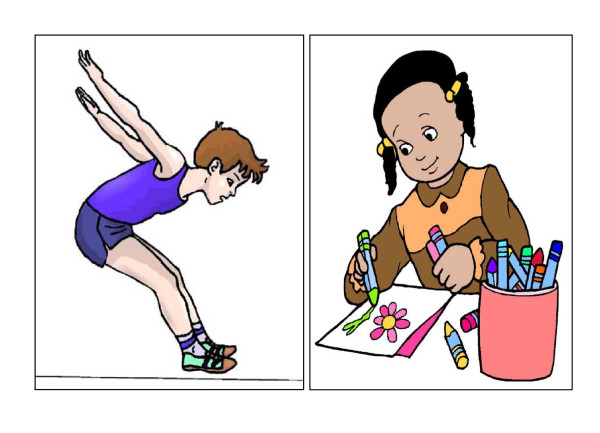
Examples of picture cards used in the BONES Physical Activity Survey. a) Jumping b) Drawing/Coloring.